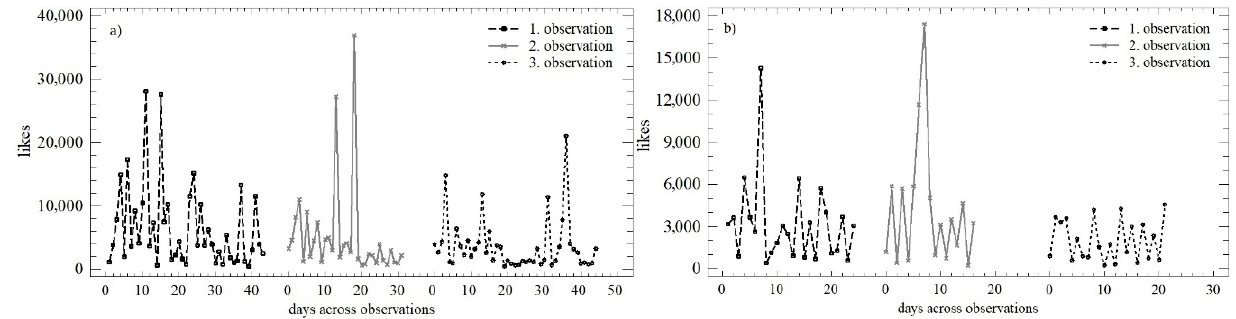
Figure 6. Scatterplot of the numbers of likes in the observation periods: ( a ) working days; ( b ) weekend.